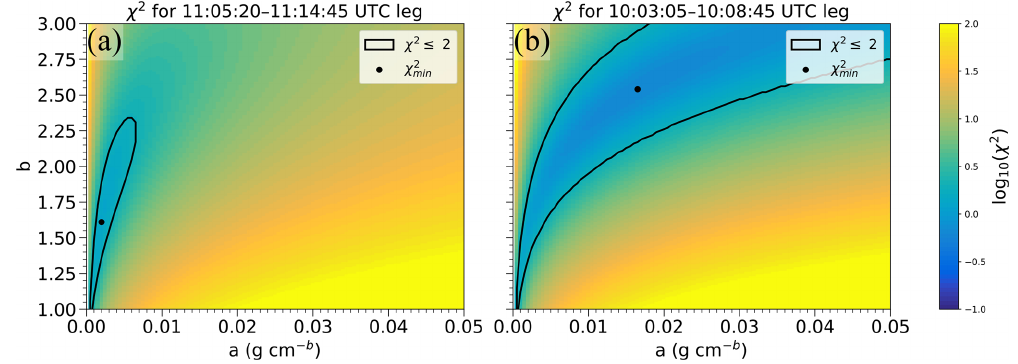
Figure 13. χ 2 statistic in ( a,b ) phase space for the (a) 11:05:20–11:14:45UTC and (b) 10:03:05–10:08:45UTC flight legs on 25 April 2011. Outlined regions represent χ 2 ≤ 2, and the dots represent χ 2 min